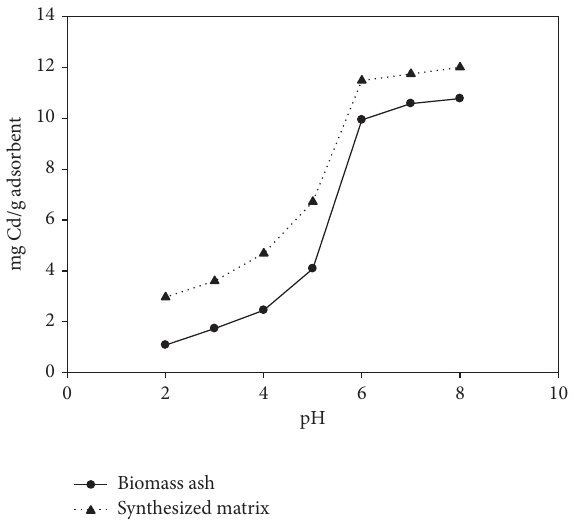
Figure 3: Langmuir model fit of modified biomass ash at different